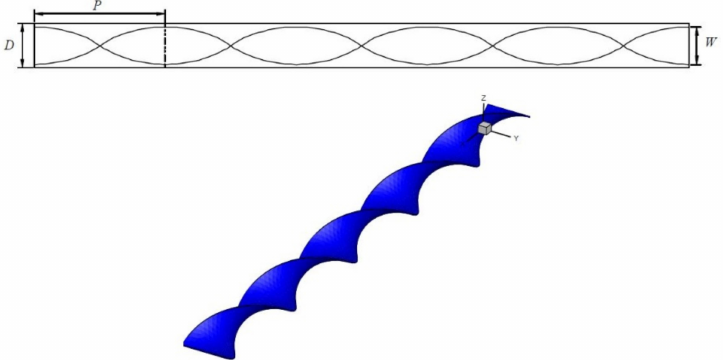
Figure 8. Twist tape inserts of solar water heaters (Yao et al.,